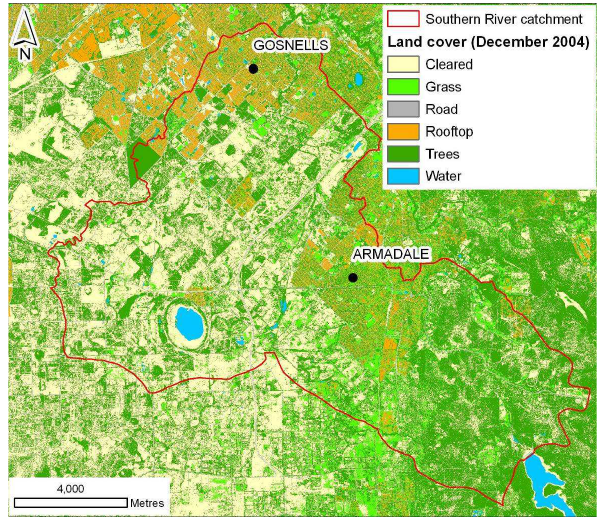
Figure 2. Land cover map; meteorological stations at Gosnells and Armadale are marked Fig. 2. Land cover map; meteorological stations at Gosnells and Armadale are